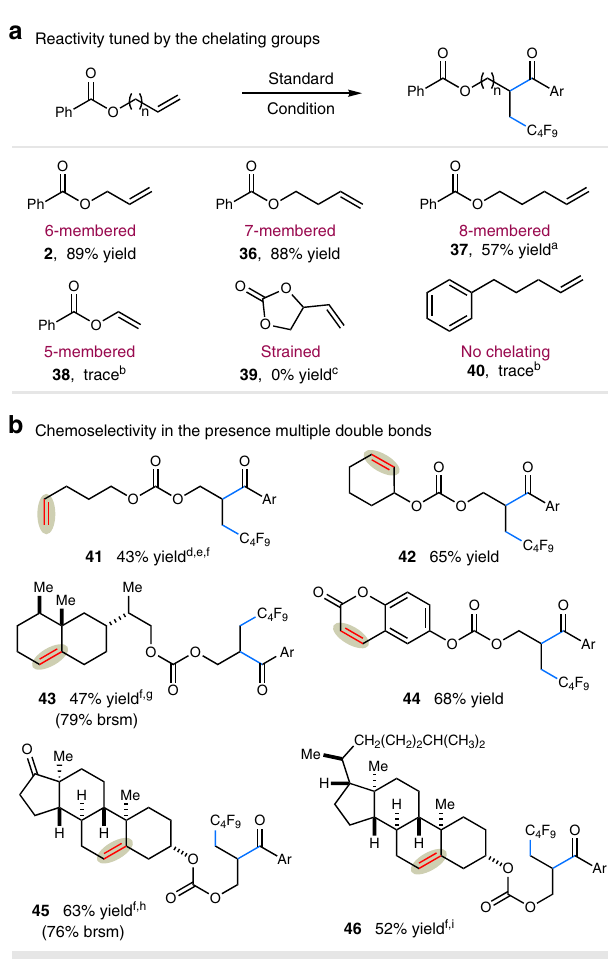
Fig. 3 Chemoselectivity guided by pendant chelating groups. a Reactivity tuned by the chelating group. b Chemoselectivity in the presence of multiple double bonds. Reaction conditions: NiCl 2 (cid:129) glyme (10 mol%), dtbbpy (20 mol%), alkene (1.0 equiv.), C 4 F 9 I (1.0 equiv.), acyl chloride (1.5 equiv.), Mn (3.0 equiv.), CH 3 CN [0.1 M], 25 o C, 20 h, see Supplementary Methods. All cited yields are isolated yields. Ar = 4- tert -butylphenyl. a 36% of C 4 F 9 -alkene byproduct isolated. b Alkene consumed. c Alkene remained. d Performed with 2 equiv. of alkene. e 140% of alkene recovered. f Performed in 4:1 CH 3 CN/DME [0.05 M]. g 41% of alkene recovered. h 17% of alkene recovered. i 48 h